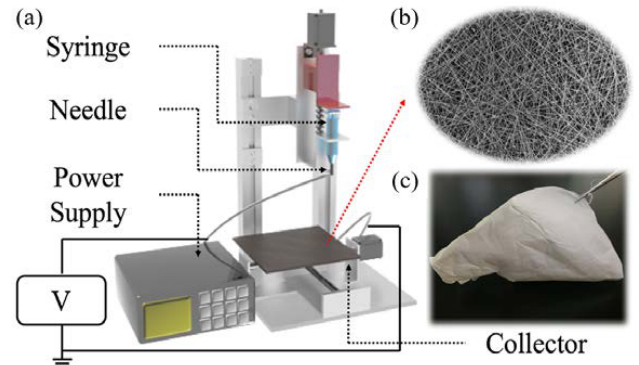
Figure 1. Preparation of the IMQ-PCL nanofibrous mesh: ( a ) Schematic representation of the ES process; ( b ) SEM image of the IMQ-PCL nanofibrous meshes; ( c ) The IMQ-PCL nanofibrous mesh obtained from the copper collector.